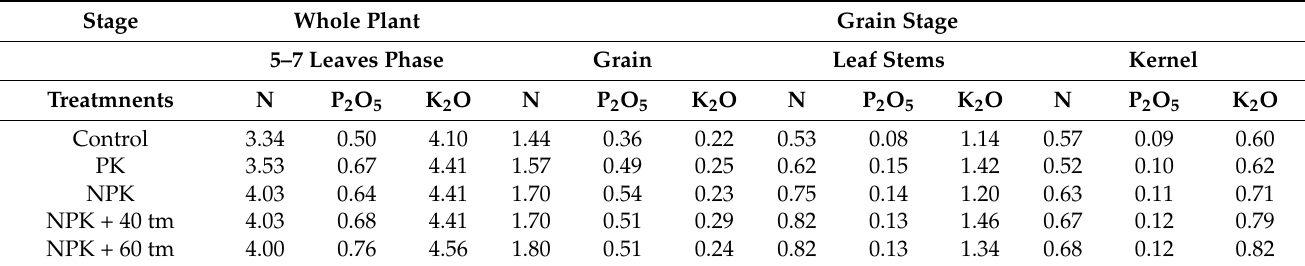
Table 4. Influence of mineral and organic fertilizers on the content of nutrients in the maize plant (% on the dry matter), Arman hybrid.